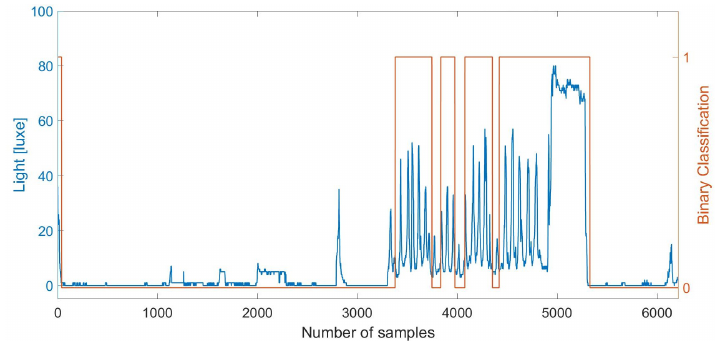
Figure 4. Outdoor–indoor transition (OITransition) classification using light at night. The binary flag of 1 (orange line and right axis) indicates indoor